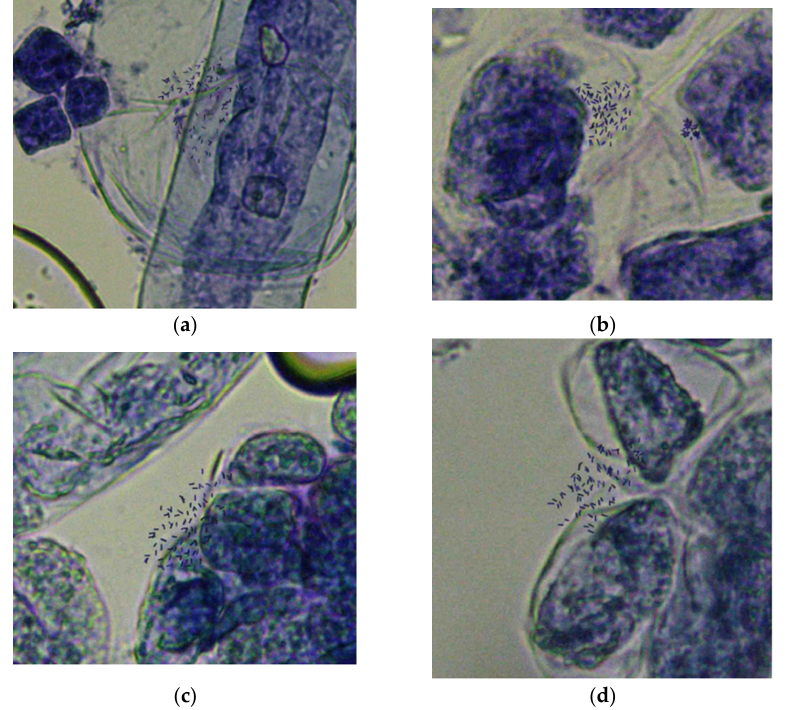
Figure 1. Metaphase chromosomes of ROC25 and Yunzhe89 ‐ 7 sugarcane varieties and their hybrid offspring. ( a ) ROC25; ( b ) Yunzhe89 ‐ 7; ( c ) Zhongzhe 1 sugarcane; ( d ) G160.